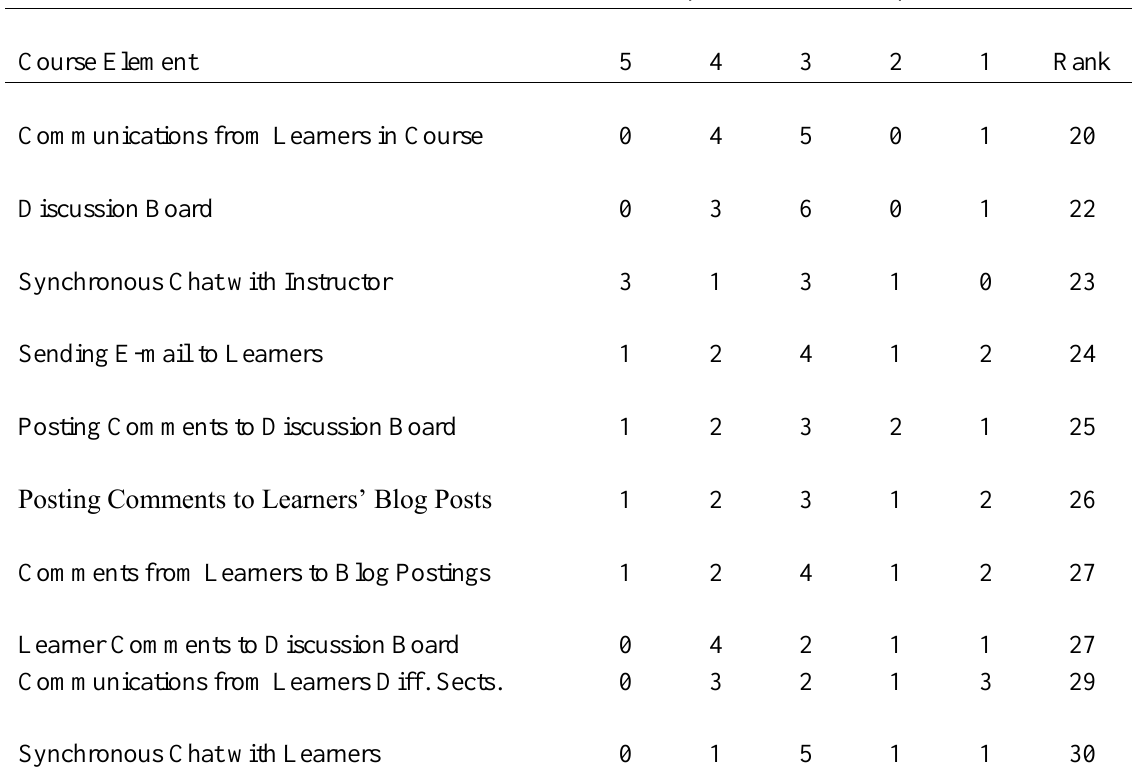
Response Frequencies Most